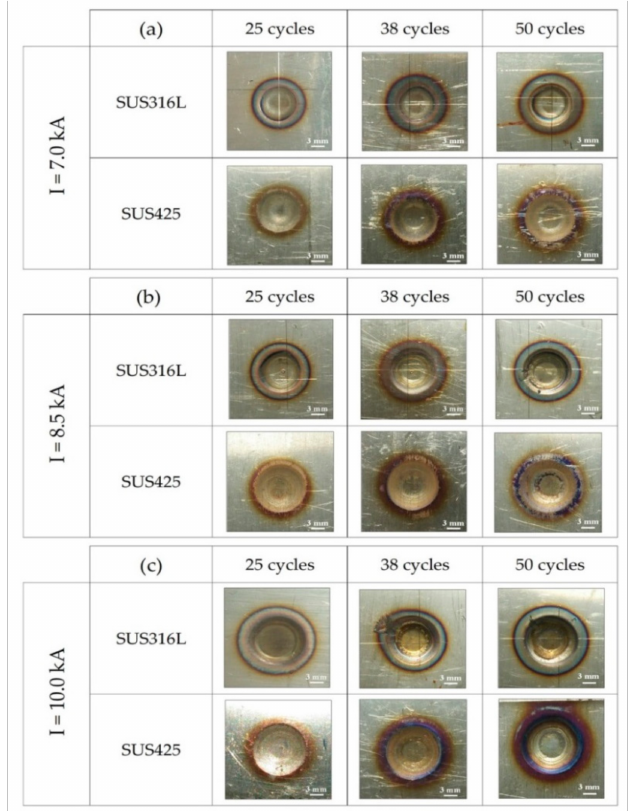
Figure 3. Visual appearances of SUS316L / SUS425 lap joints under 25-, 38-, 50-cycle welding times: ( a ) 7.0; ( b ) 8.5; ( c ) 10.0 kA weld